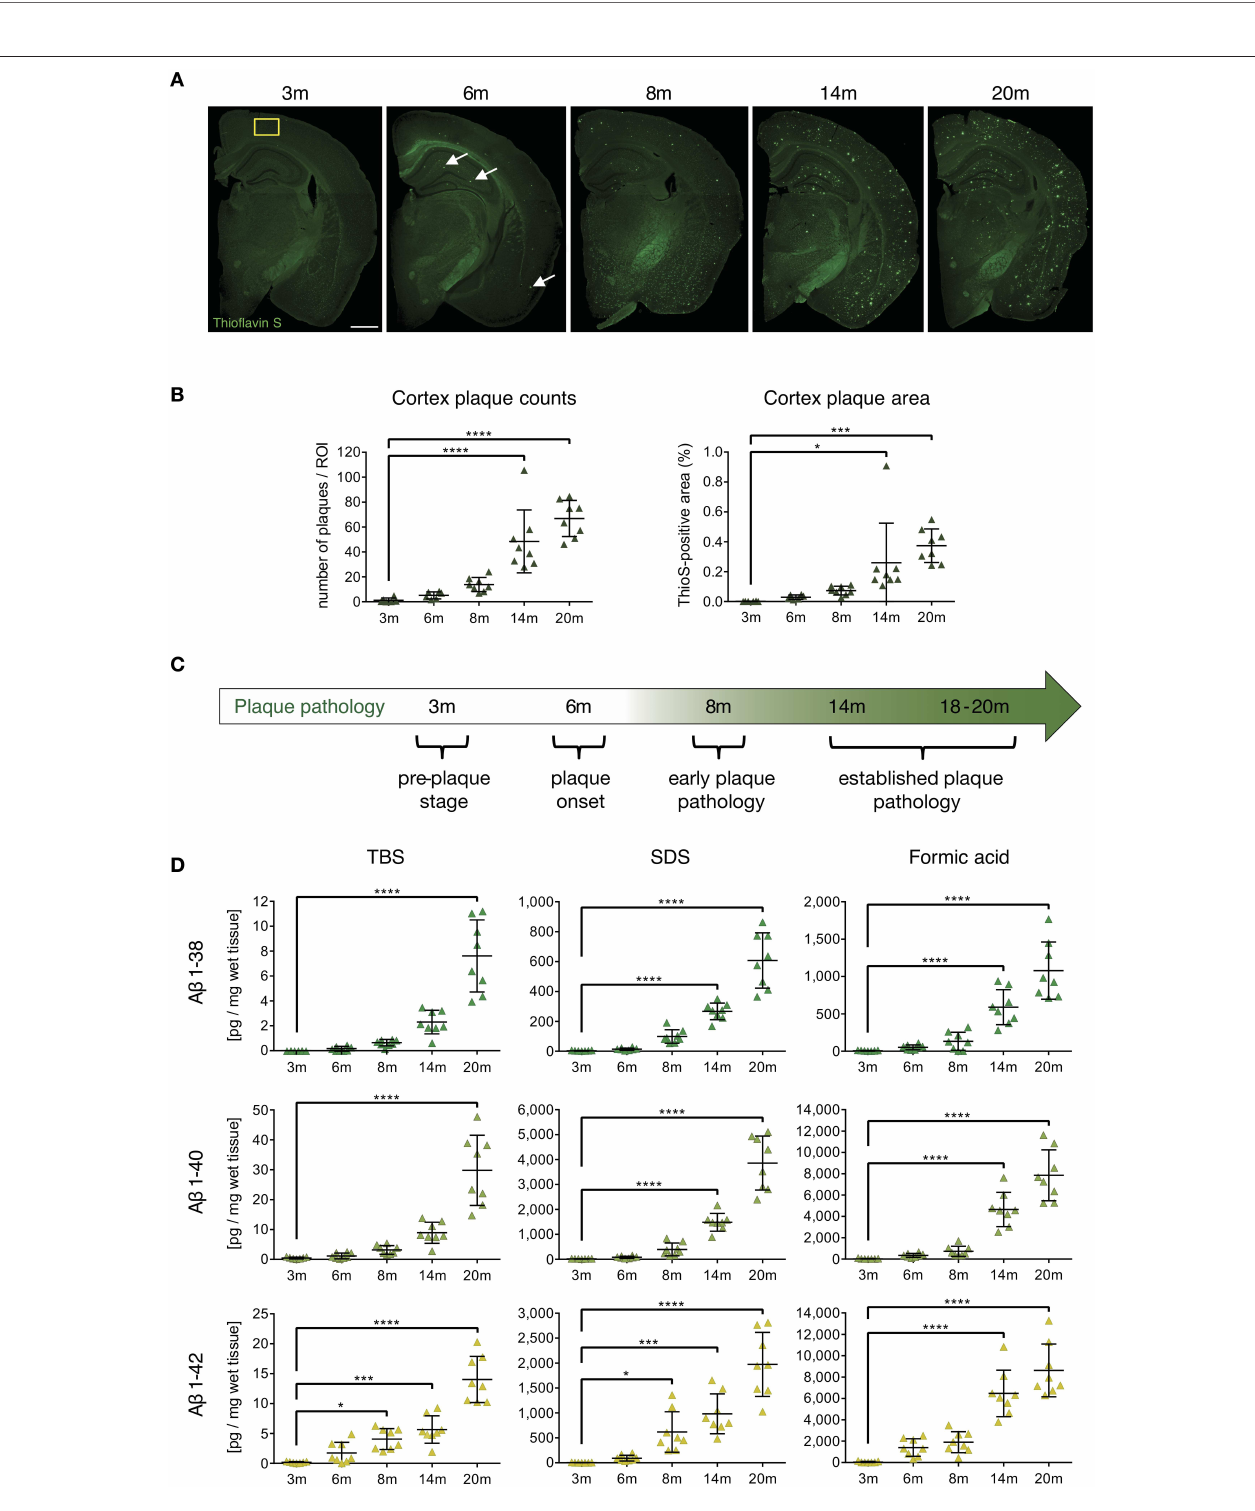
FIGURE 1 | Characterization of cerebral plaque load and A β species in the APP-PS1 transgenic mouse model. (A) Representative images of Thioflavin-S staining of coronal sections from APP-PS1 transgenic (tg) mice at different ages. First occasional plaques are observed at 6 months of age in cortex and anterior hippocampus (white arrows). Diffuse staining in corpus callosum and other white matter bundles is non-specific, as it is observed in non-tg mice as well. Scale bar = 0.8mm. Yellow box (0.33 mm 2 ) shows area used for quantification. (B) Quantitative analysis of plaque load in the cortex shows progressively increased beta-amyloid plaque numbers with age. Only significant differences between pre-plaque stage (3m) and other plaque pathology stages are shown. (C) Schematic of identified stages of